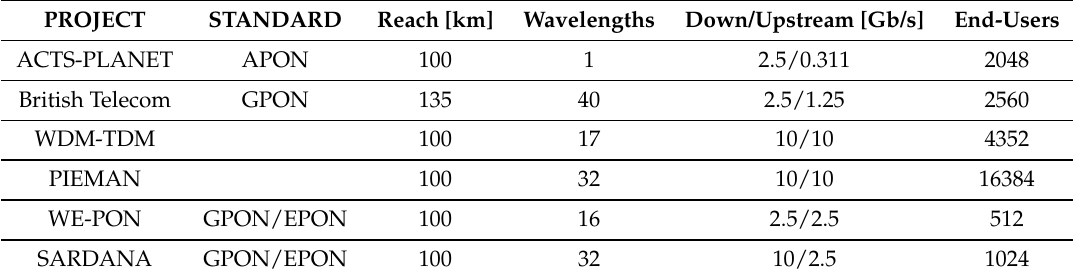
Table 3. Realized long-reach passive optical network (LR-PON) projects